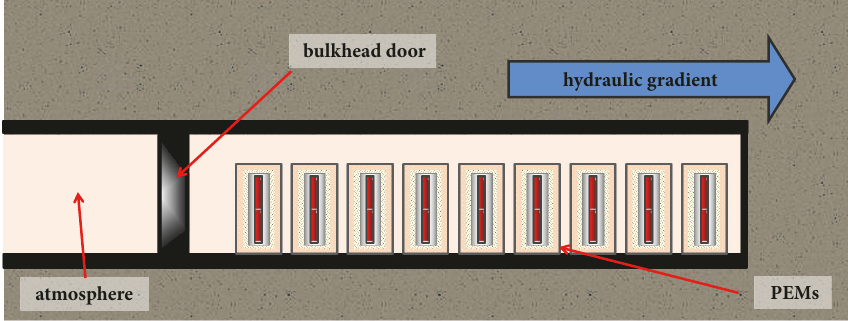
Figure 6: Cavern emplacement variant using